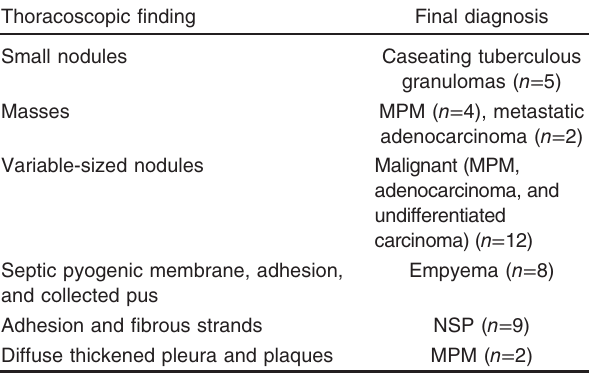
Large nodule over visceral